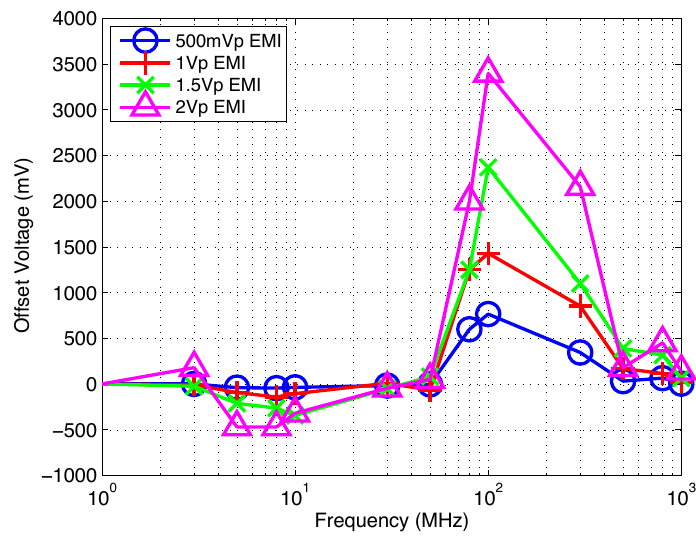
Figure 3. EMI induced offset in ua741: interferences coupled to the output pin.